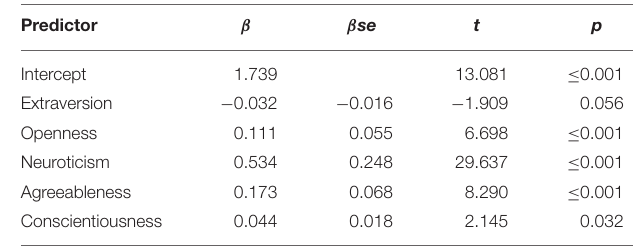
TABLE 6 | Regression analysis to predict the COVID-19-fear by the Big Five